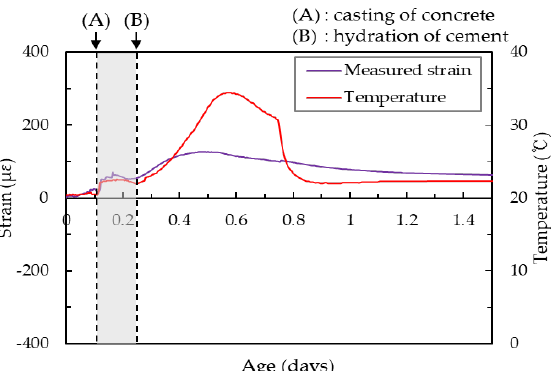
Figure 7. Initial strain and temperature behavior of HSC.